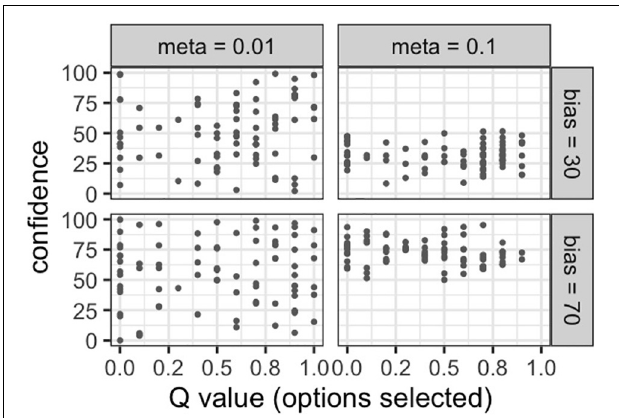
FIGURE 6 | Simulation of the association between the probability of a correct answer and confidence in different metacognitive abilities.